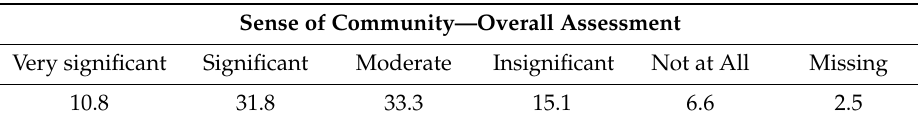
Table 9. Overall assessment of the e ff ects on the Sense of